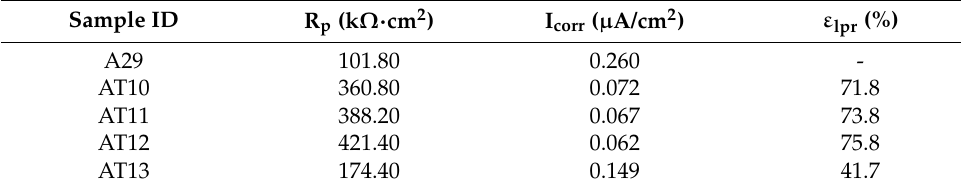
Table 4. LPR parameters for the samples solutionized at different temperatures. Sample